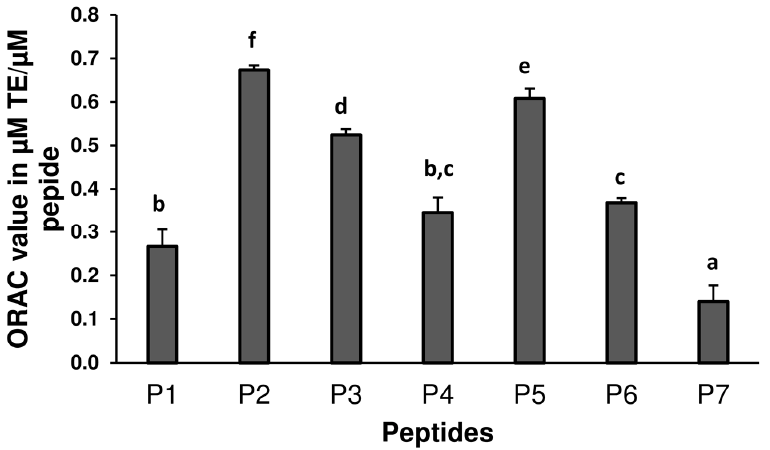
Figure 1. Oxygen radical absorbance capacity (ORAC) values peptides (µmol Trolox equivalent/µmol peptide). FNDRLRQGQLL (P1), GLVYIL (P2), GQTV (P3), GQTVFNDRLRQGQLL (P4), YHNAP (P5), YHNAPGLVYIL (P6), and DVNNNANQLEPR (P7). Each peptide was tested in triplicate. Data are means ± STDEV. Different letters indicate significant differences ( p < 0.05) in a post-hoc Tukey’s Honest Significant Differences test.